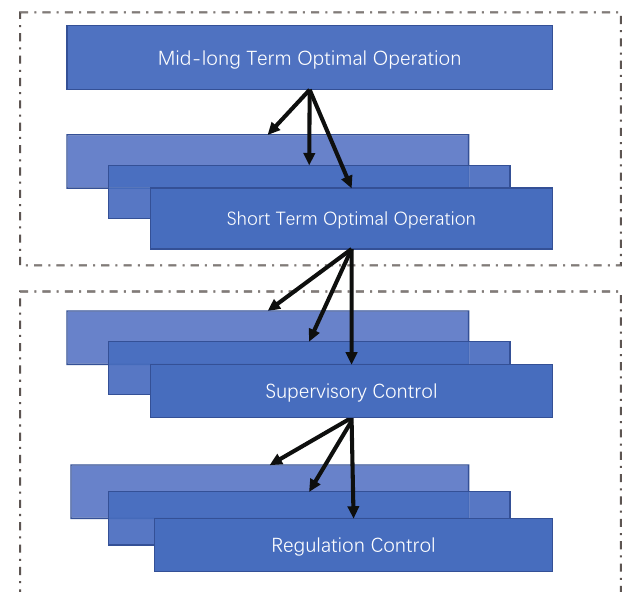
Figure 1. The hierarchical structure of the natural gas pipeline control